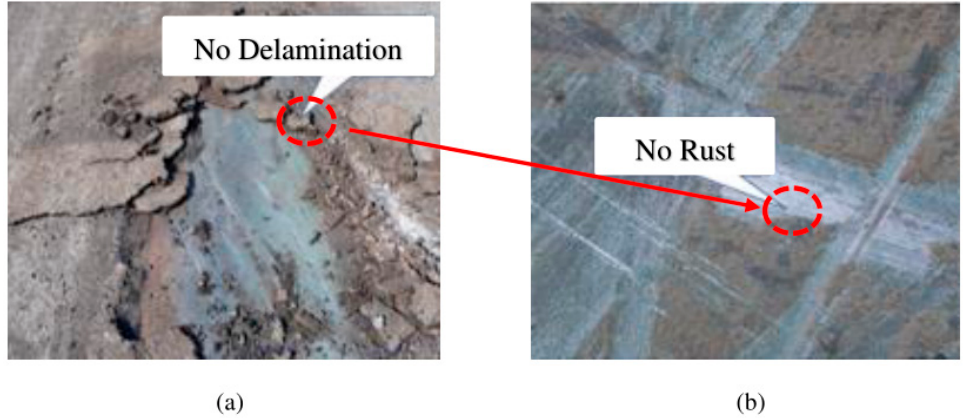
Figure 2. An area with good bonding between the deck pavement and the steel deck plate: ( a ) a well-bonded area; ( b ) steel plate not rusted.